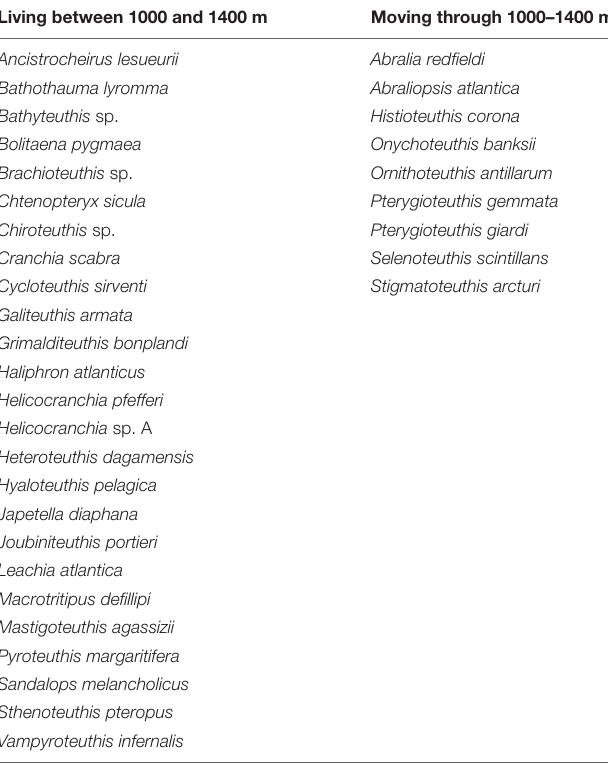
TABLE 4 | Cephalopod species found living between (10% or more of abundance) or moving through 1000–1400 m. Living between 1000 and 1400